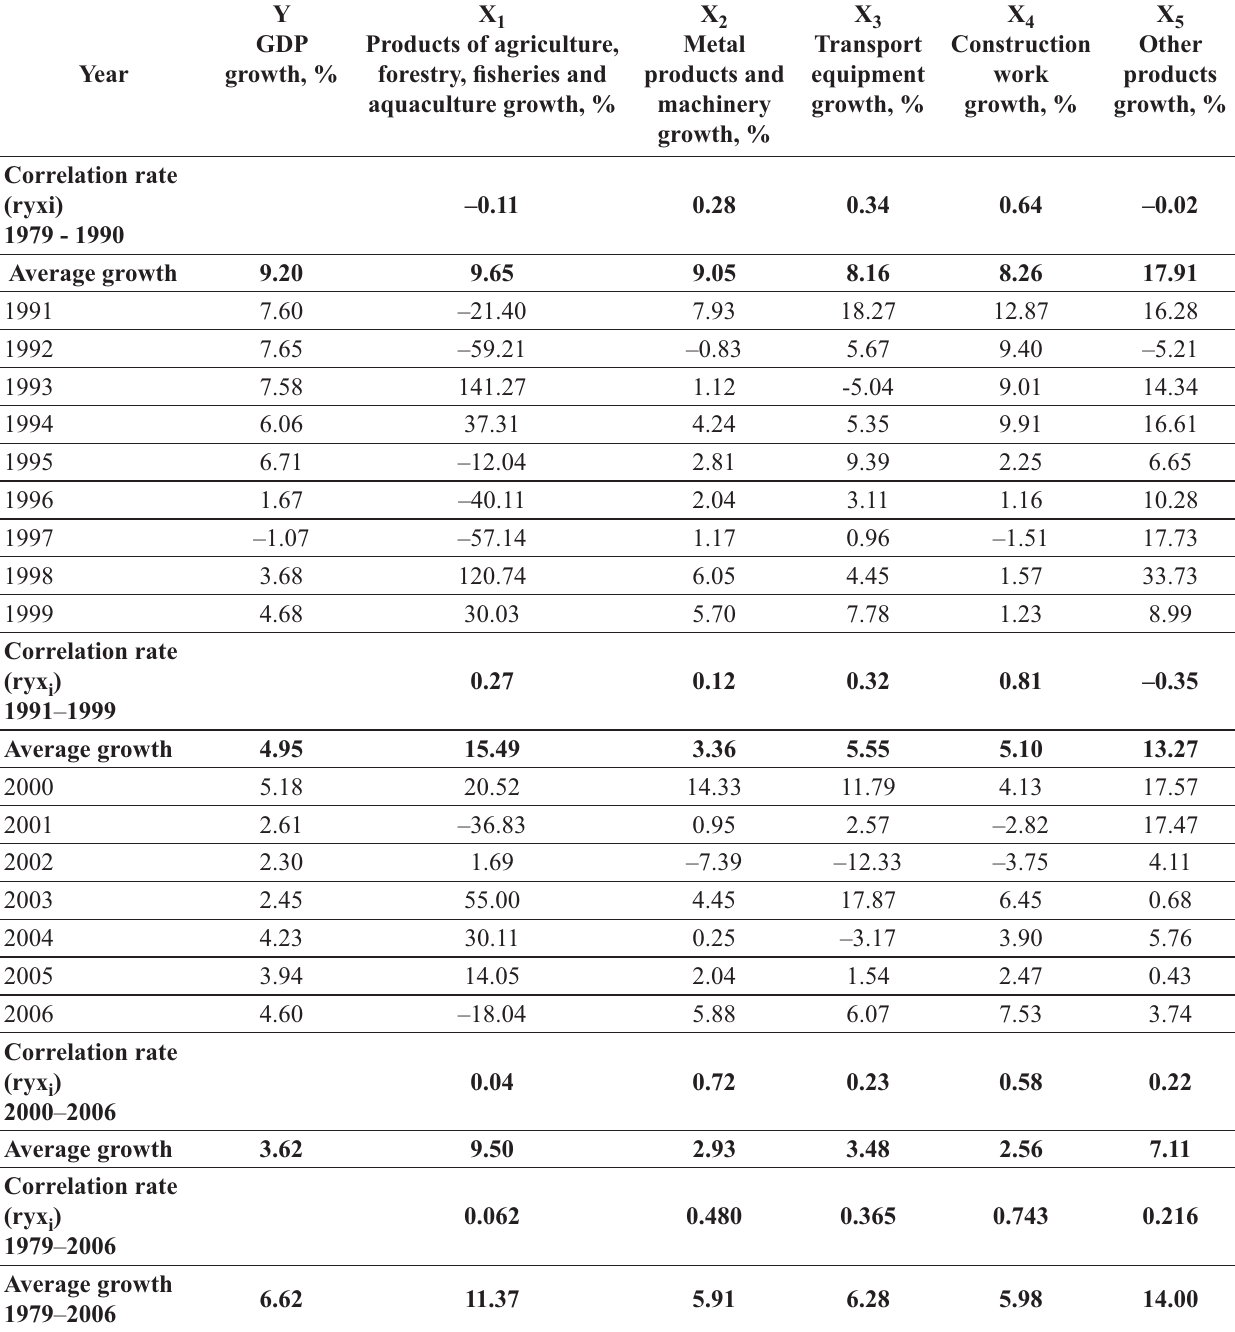
Table 3. Relationship between structural investment and GDP growth in Austria (Data source: EUROSTAT, calculations performed by